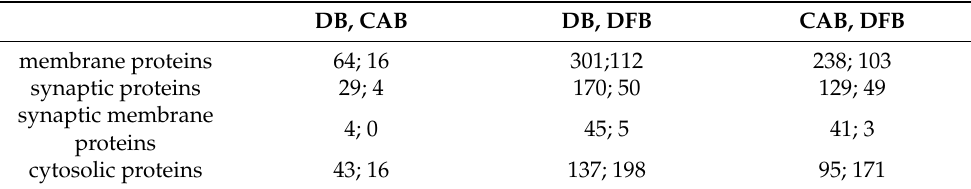
Figure 4. Volcano plot of proteins for which different levels were found between CAB and DFB homogenization buffers (green—overrepresented in CAB buffer; red—overrepresented in DFB buffer); indicated are protein clusters which were identified by GO analysis with application of Markov clustering method (FDR < 0.01). Table 3. Number of protein groups of interest for which different levels were found between each pair of